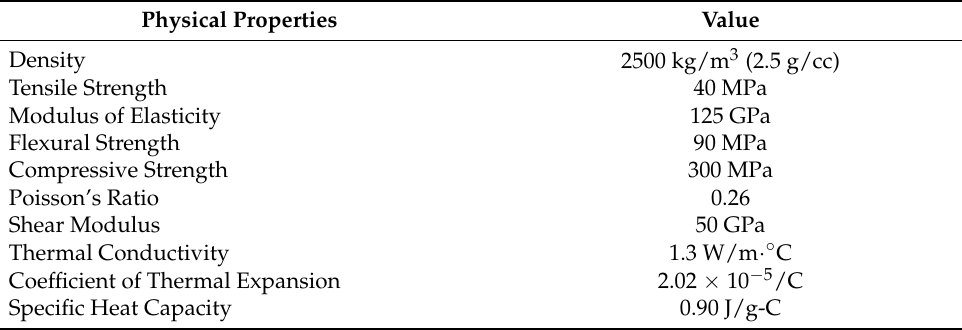
Table 1. Material characteristics of stone grill plate.